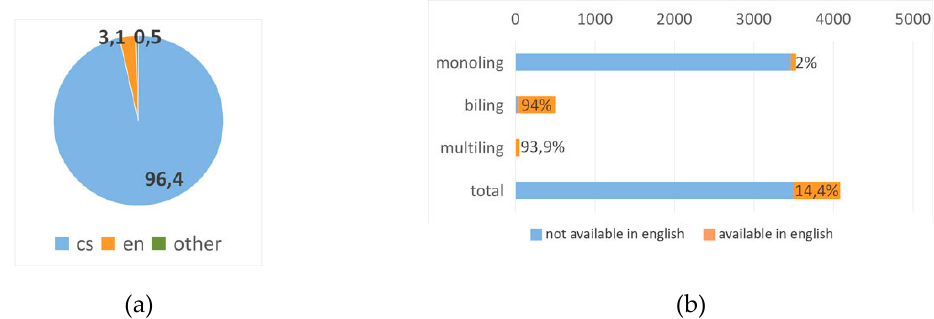
Figure A6. Visualization of the results for domain cz. ( a ) Primary languages pie chart and ( b ) English